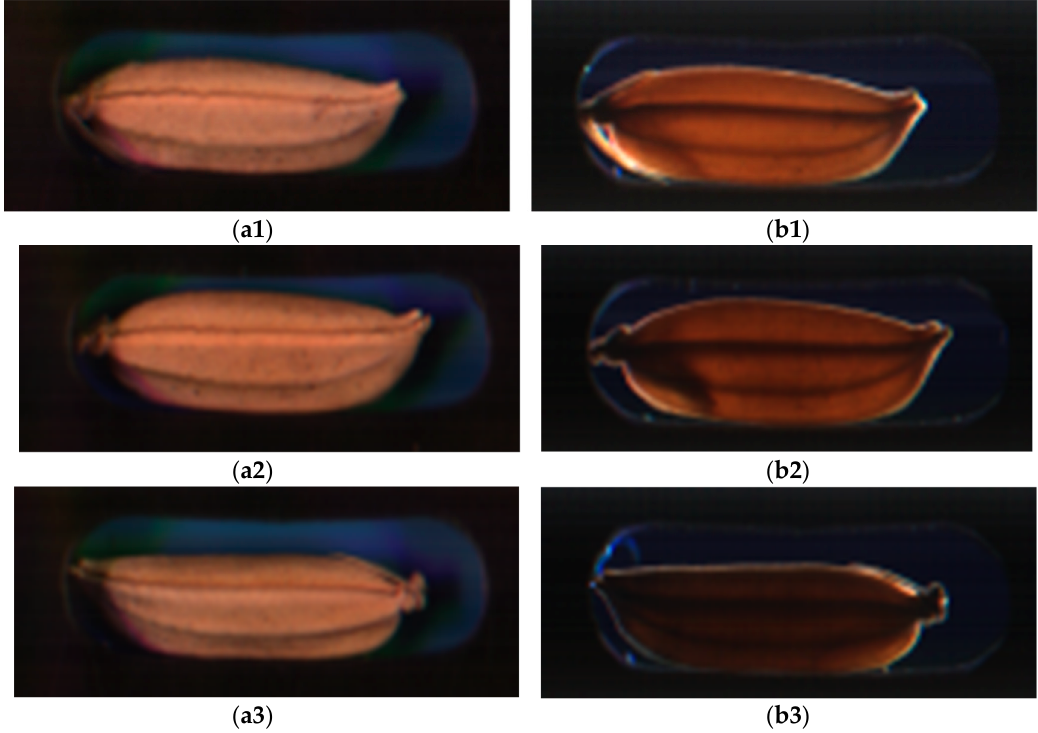
Figure 6 . Pictures of the paddy rice kernels from the visual camera ( a ) and translucency camera using polarized light ( b ). The first kernel is a perfect kernel without dark areas. The bottom kernel is completely dark which indicates high chalkiness. The middle kernel has a local dark region, which indicates a chalky area close to the germ.